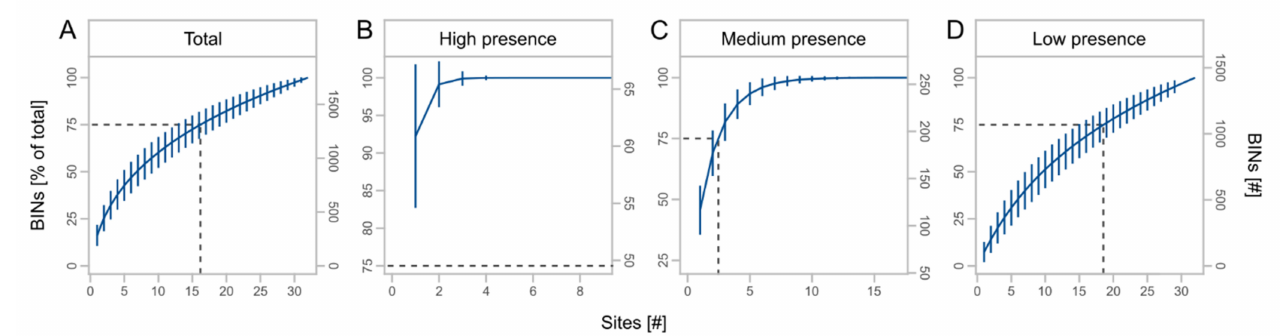
Figure 5. Mean cumulative proportion and number of BINs ± SD at different number of sites for total BINs ( A ) and subsets ( B – D ) with high (taxa caught at 25 to 32 sites), medium (taxa caught at 9 to 24 sites), and low presence (taxa caught at 1 to 8 sites). Dashed lines indicate the number of sites at 75% of the total BINs. Note different scale of x- and